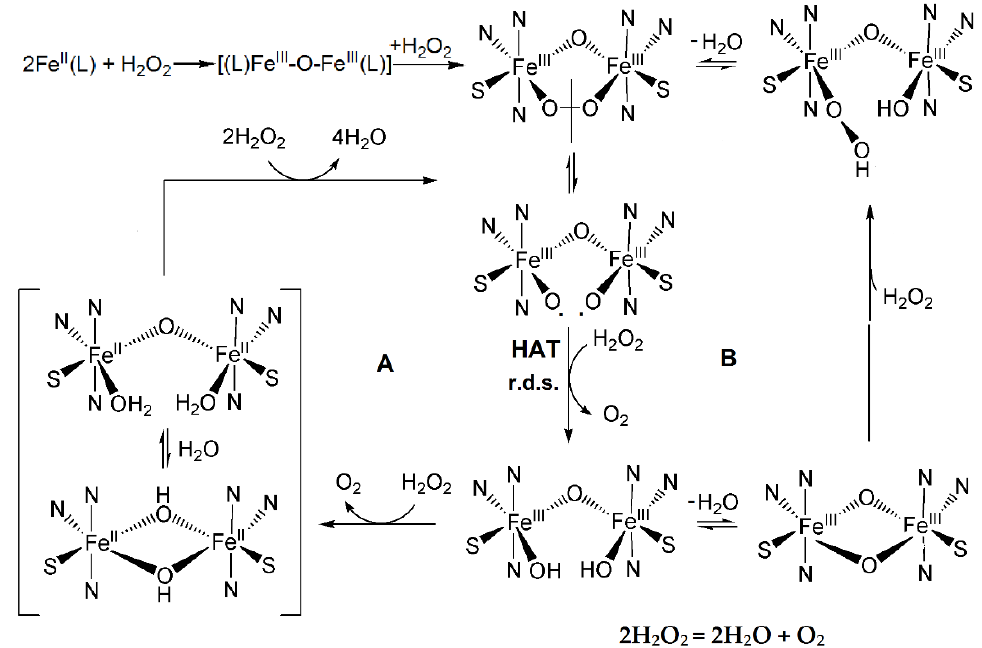
Scheme 3. Proposed mechanism for the formation of Fe III2 ( μ -O)( μ -1,2-O 2 )(L 1 -L 4 ) 2 (Solv) 2 ] 2+ ( 5 – 8 ) complexes and their catalase-like